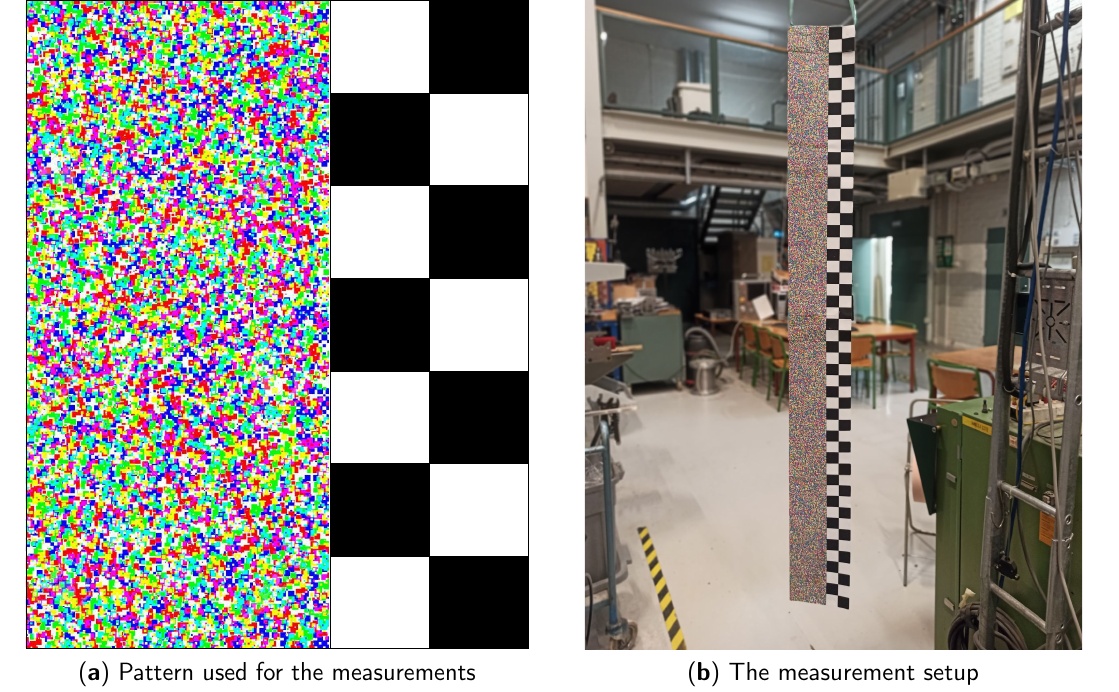
Figure 2. The reference object—random colour noise pattern along with a chequerboard